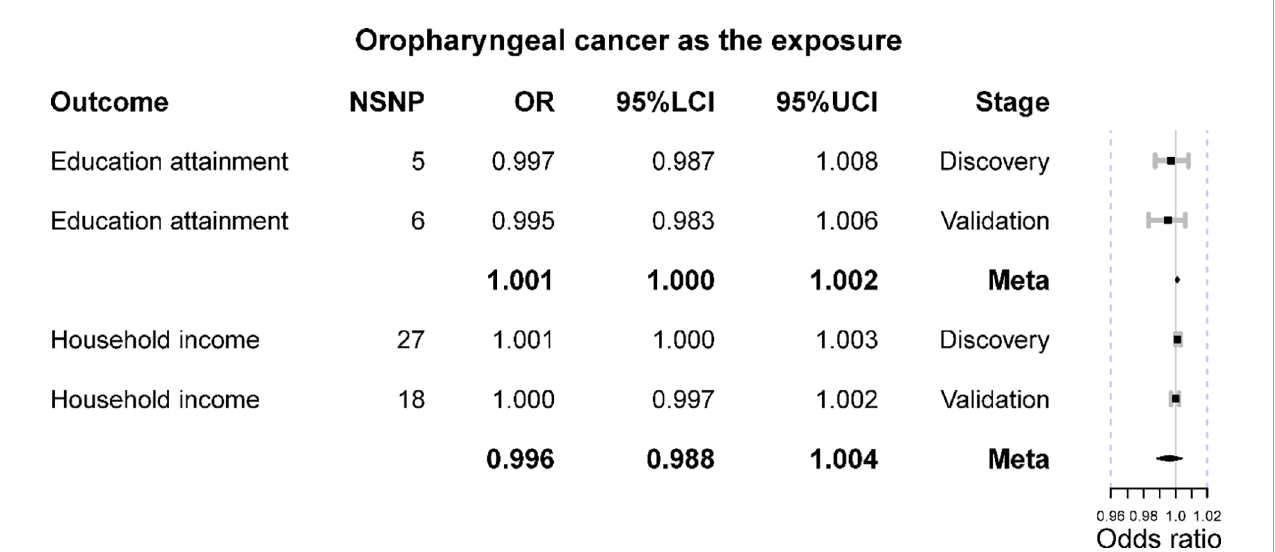
FIGURE 3 The Mendelian randomization results of oropharyngeal cancer on education attainment and household income. OR is the odds ratio; 95%LCI is the lower limit of 95% con fi dence interval; 95%UCI is the lower limit of 95% con fi dence interval.